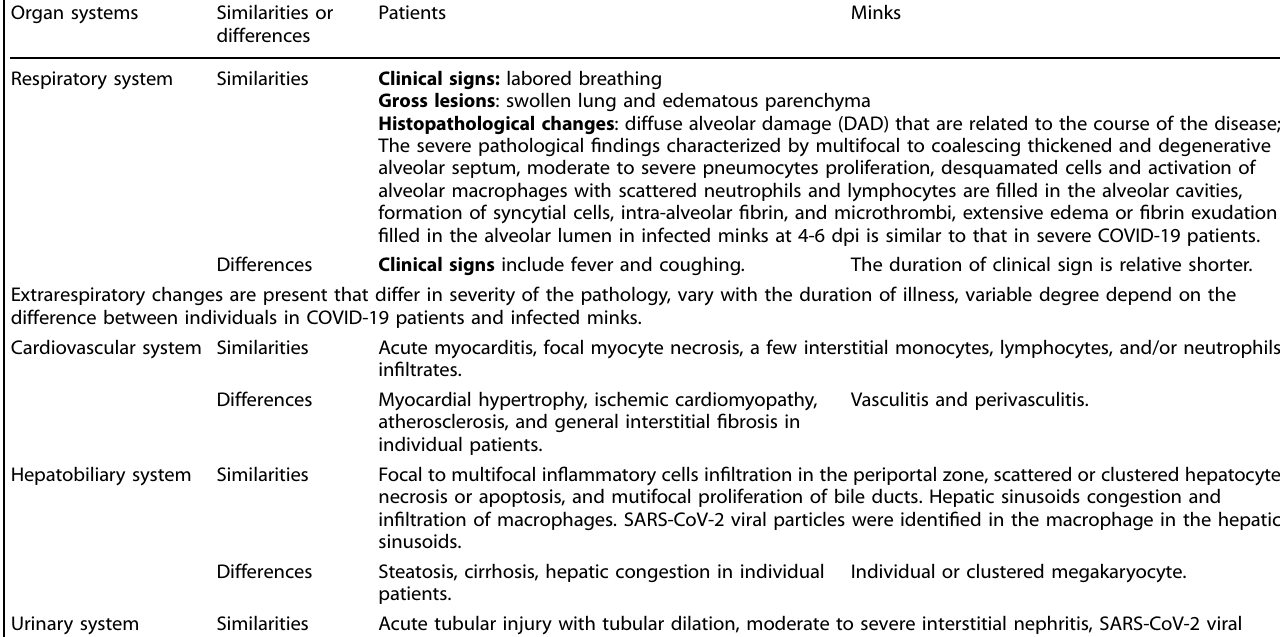
Table 1. The comparative pathological features between autopsy results of patients and laboratory minks that infected by SARS-CoV-2 Organ